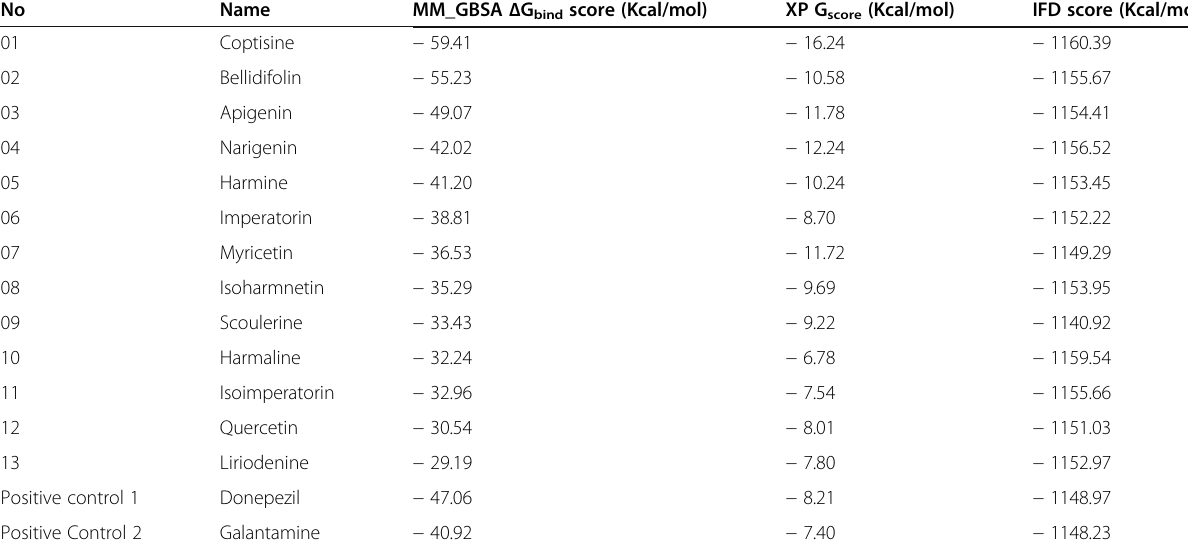
Table 4 The results of the MM_GBSA and IFD studies of the 13 ligands selected from the SP and XP docking studies along with the positive